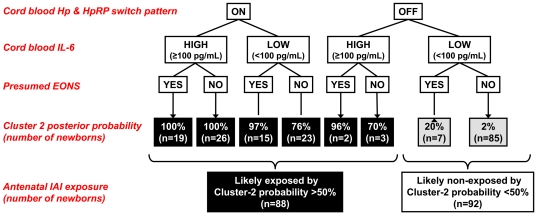
Clustering flowchart based on probability of “antenatal IAI exposure”.Posterior probabilities for inclusion in cluster-2 were calculated for all 8 possible combinations of indicators (haptoglobin & haptoglobin [Hp&HpRP] switch pattern, cord blood IL-6, presumed EONS) and their modal characteristics. The number of newborns presenting each combination is included in parentheses. All newborns with cluster-2 probability levels >50% (black boxes) were considered “likely exposed”. Alternatively, a diagnosis of “likely non-exposed” was assigned to newborns with cluster-2 probability levels <50% (grey boxes).